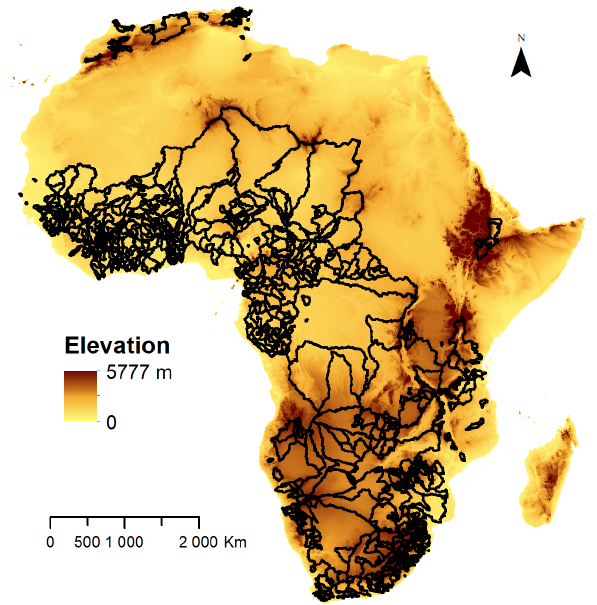
Figure 3. Map of the delineated catchment boundaries in black with elevation from HydroSHEDS digital elevation model